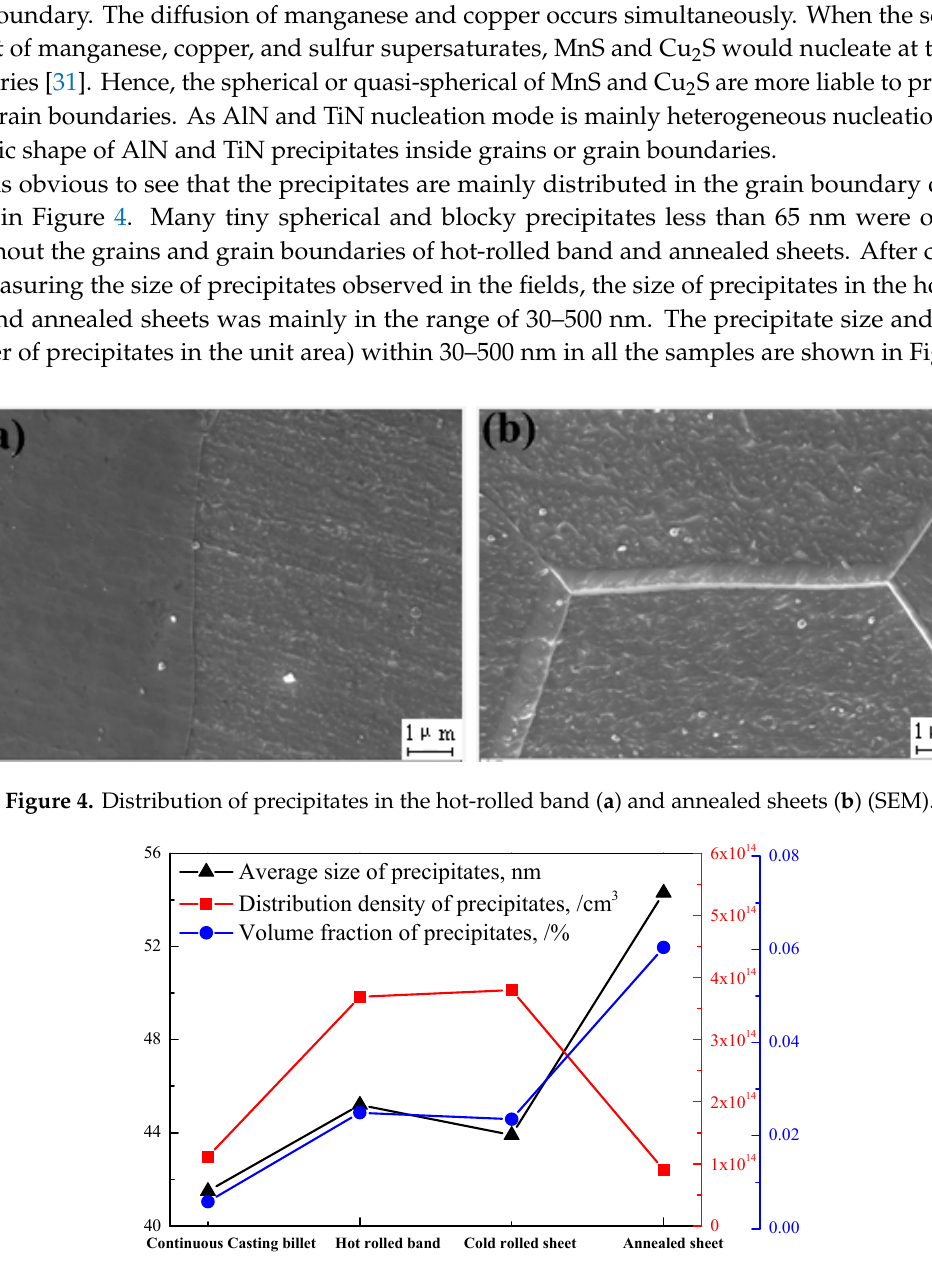
Figure 5. Statistics of precipitates in Continuous Casting billet, hot-rolled band, cold-rolled sheet, and annealed sheet.